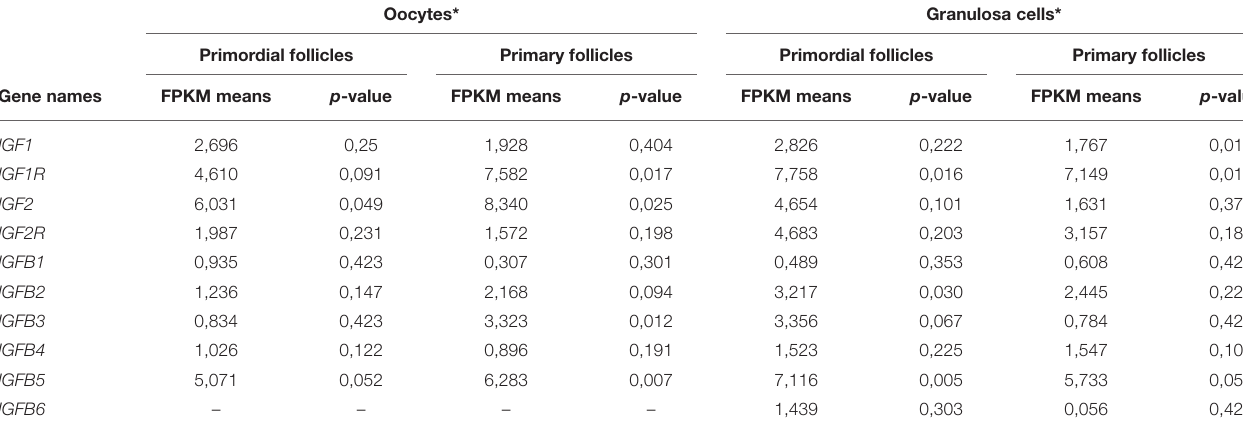
TABLE 4 | Expression of IGF1 , IGF1R , IGF2 , IGF2R, and IGFBP1-6 transcripts.